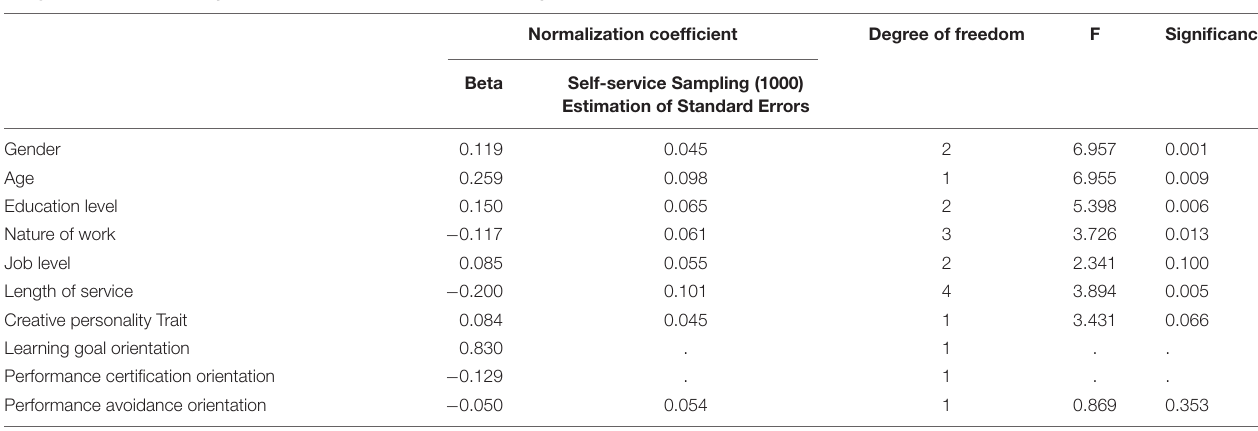
TABLE 5 | Analysis of the influence of all variables on innovation performance.